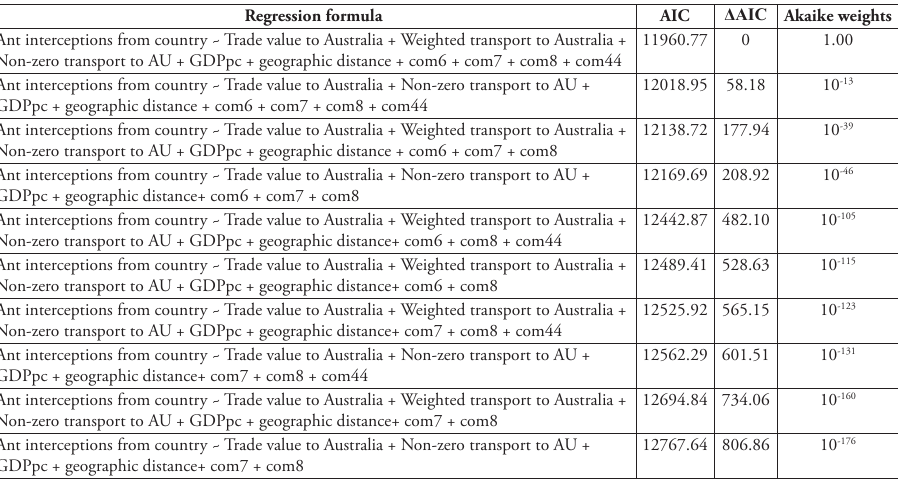
Figure 5. Ant interceptions into Australia by commodity group by year, for the top four commodity groups on which ants were found. Table 4. AIC for 10 best candidate Poisson GLMs predicting total number of ant interceptions by country. All possible model combinations of these predictors were tested (512 total models): models not shown had higher